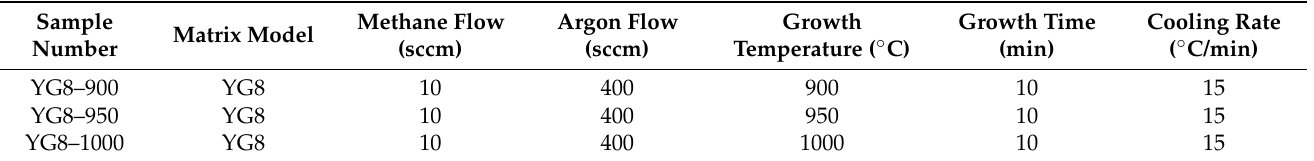
Table 2. The process parameters based on growth temperature.